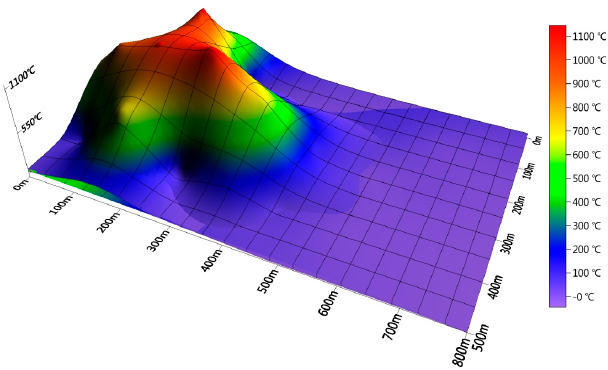
Figure 5. Temperature profile distribution during UCG simulation test (40%-O 2 ).